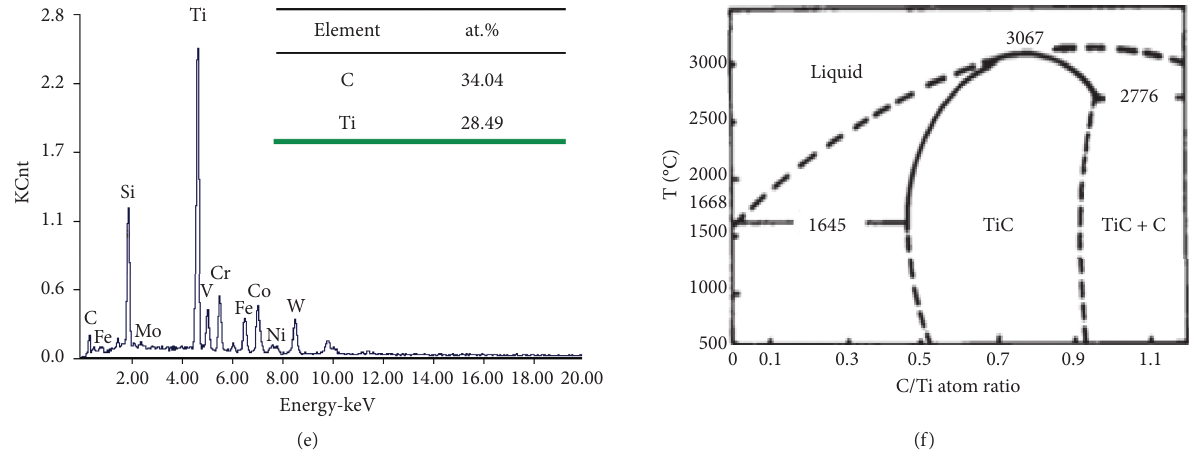
Figure 7: EDS spectrums of TiC from S1 coating. (a) Point 1. (b) Point 2. (c) Point 3. (d) Point 4 position. (e) Point 5 position. (f) Ti-C equilibrium phase